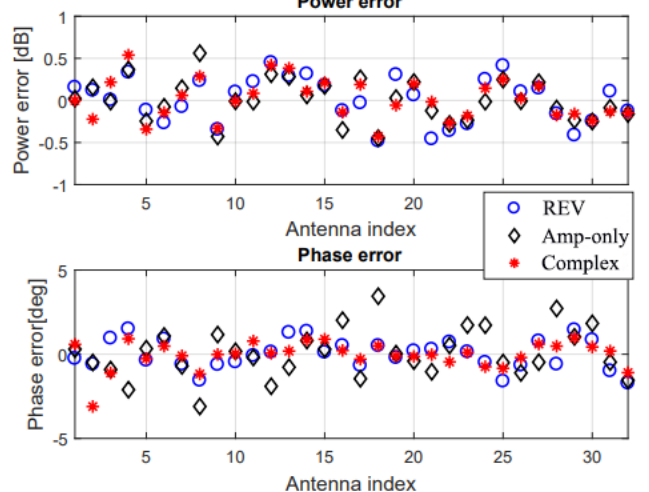
Figure 12. Array calibration errors based on three methods with scattering parameters obtained via geometry configuration ( R = 5.85